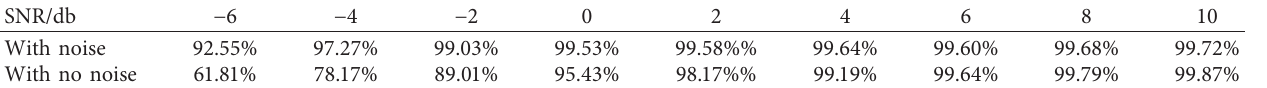
Table 2: Diagnosis accuracy of noise and no-noise input training models.